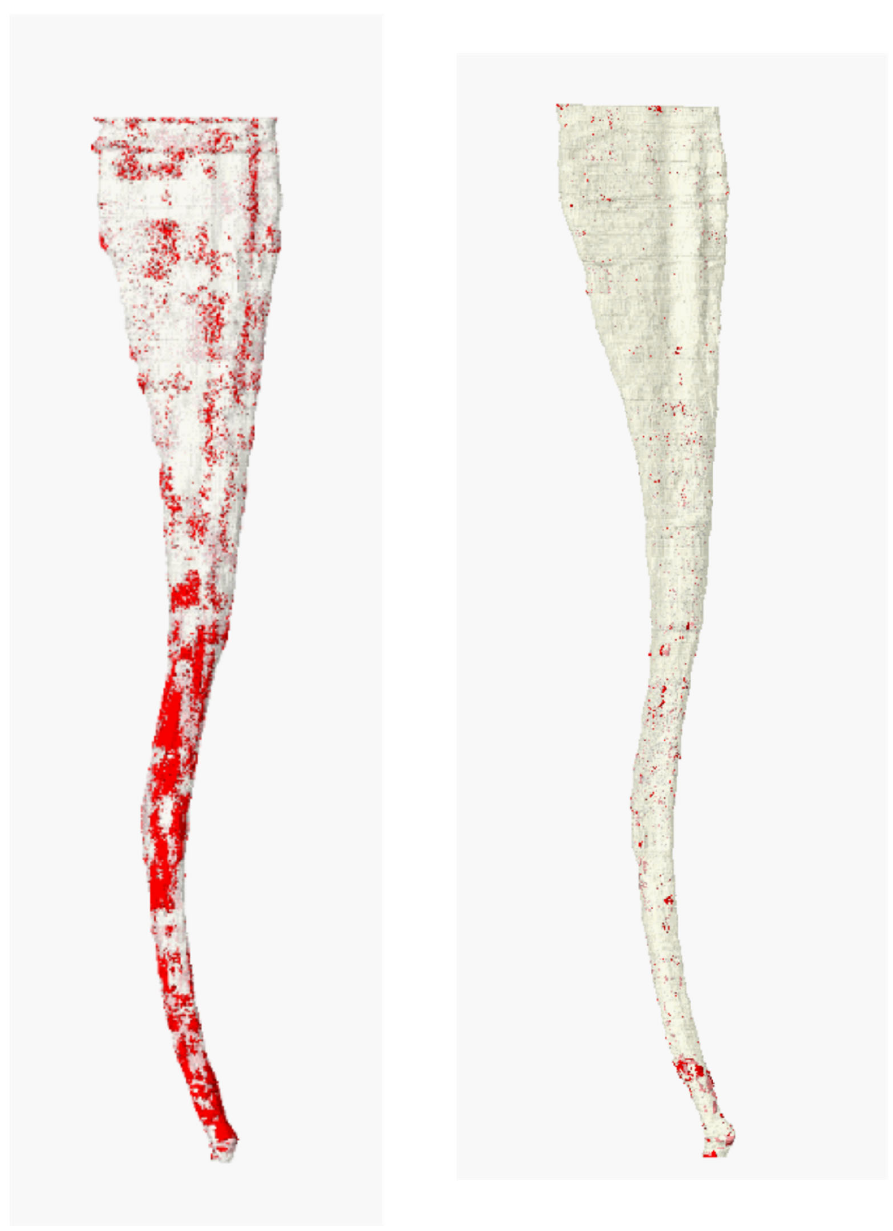
Figure 5. EB group—3D evaluation of ATHD before (image left) and after (image right) irrigant activation.